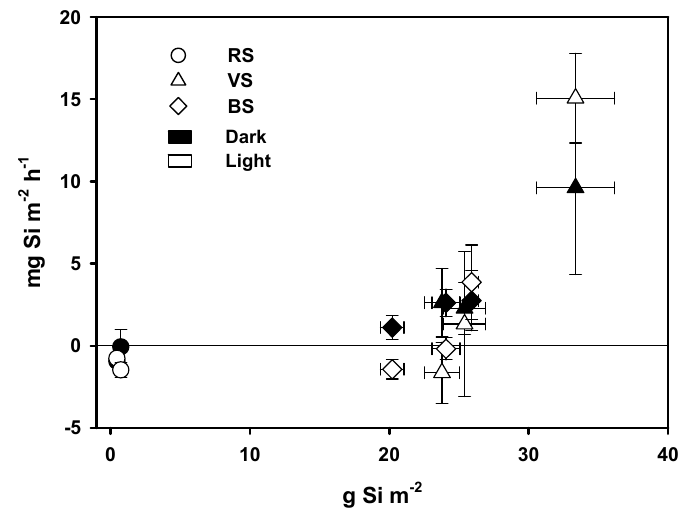
Figure 7. Average Si content in sediments and Si benthic fluxes under light and dark conditions in the three sampling sites. Error bars represent standard error.